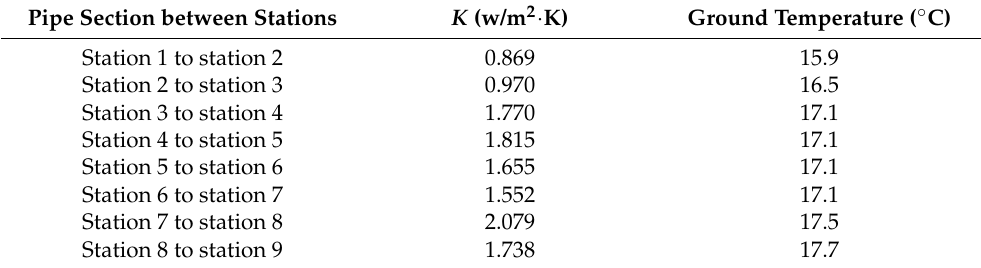
Table A1. Heat transfer coefficient K and ground temperature between stations.